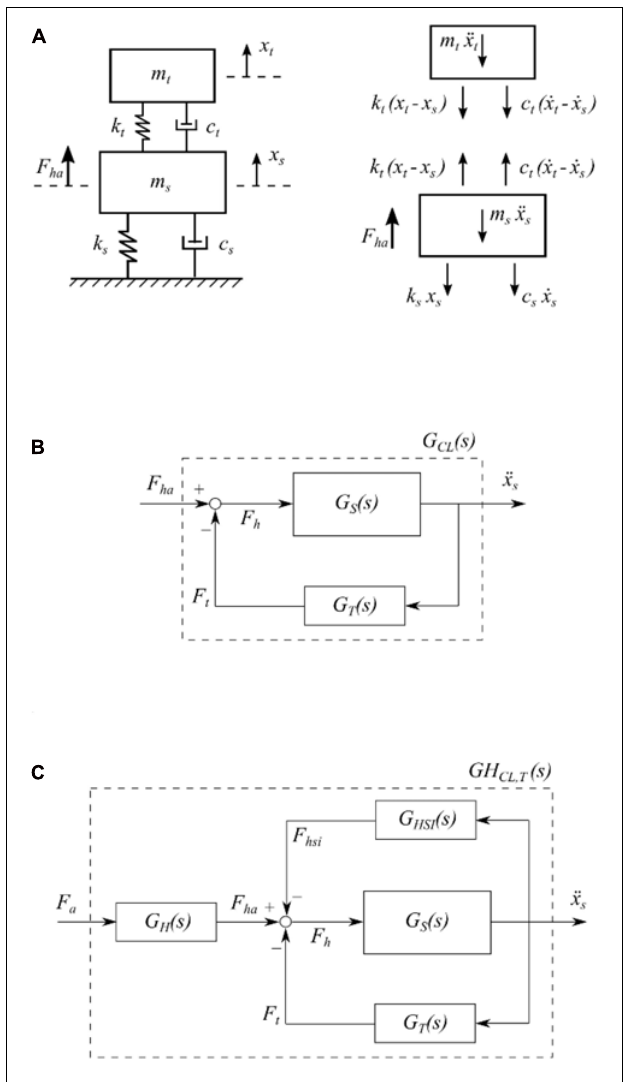
FIGURE 2 | TVA system: (A) Free body diagram, (B) Block diagram of the plant with a TVA, and (C) Block diagram of the plant with a TVA and HSI.